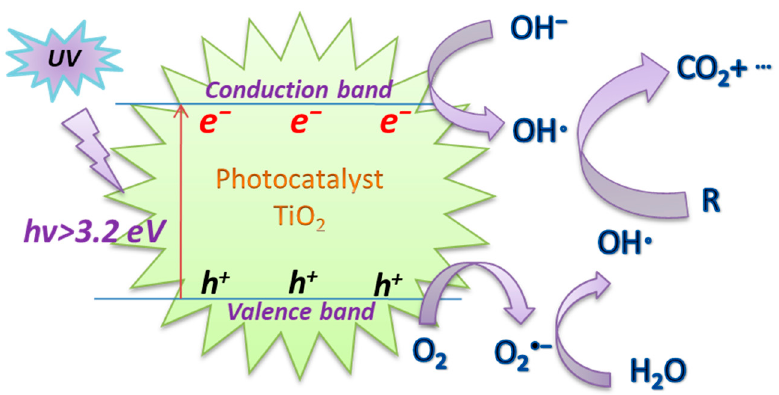
Figure 2. The mechanism of UV/TiO 2 photoactivation.